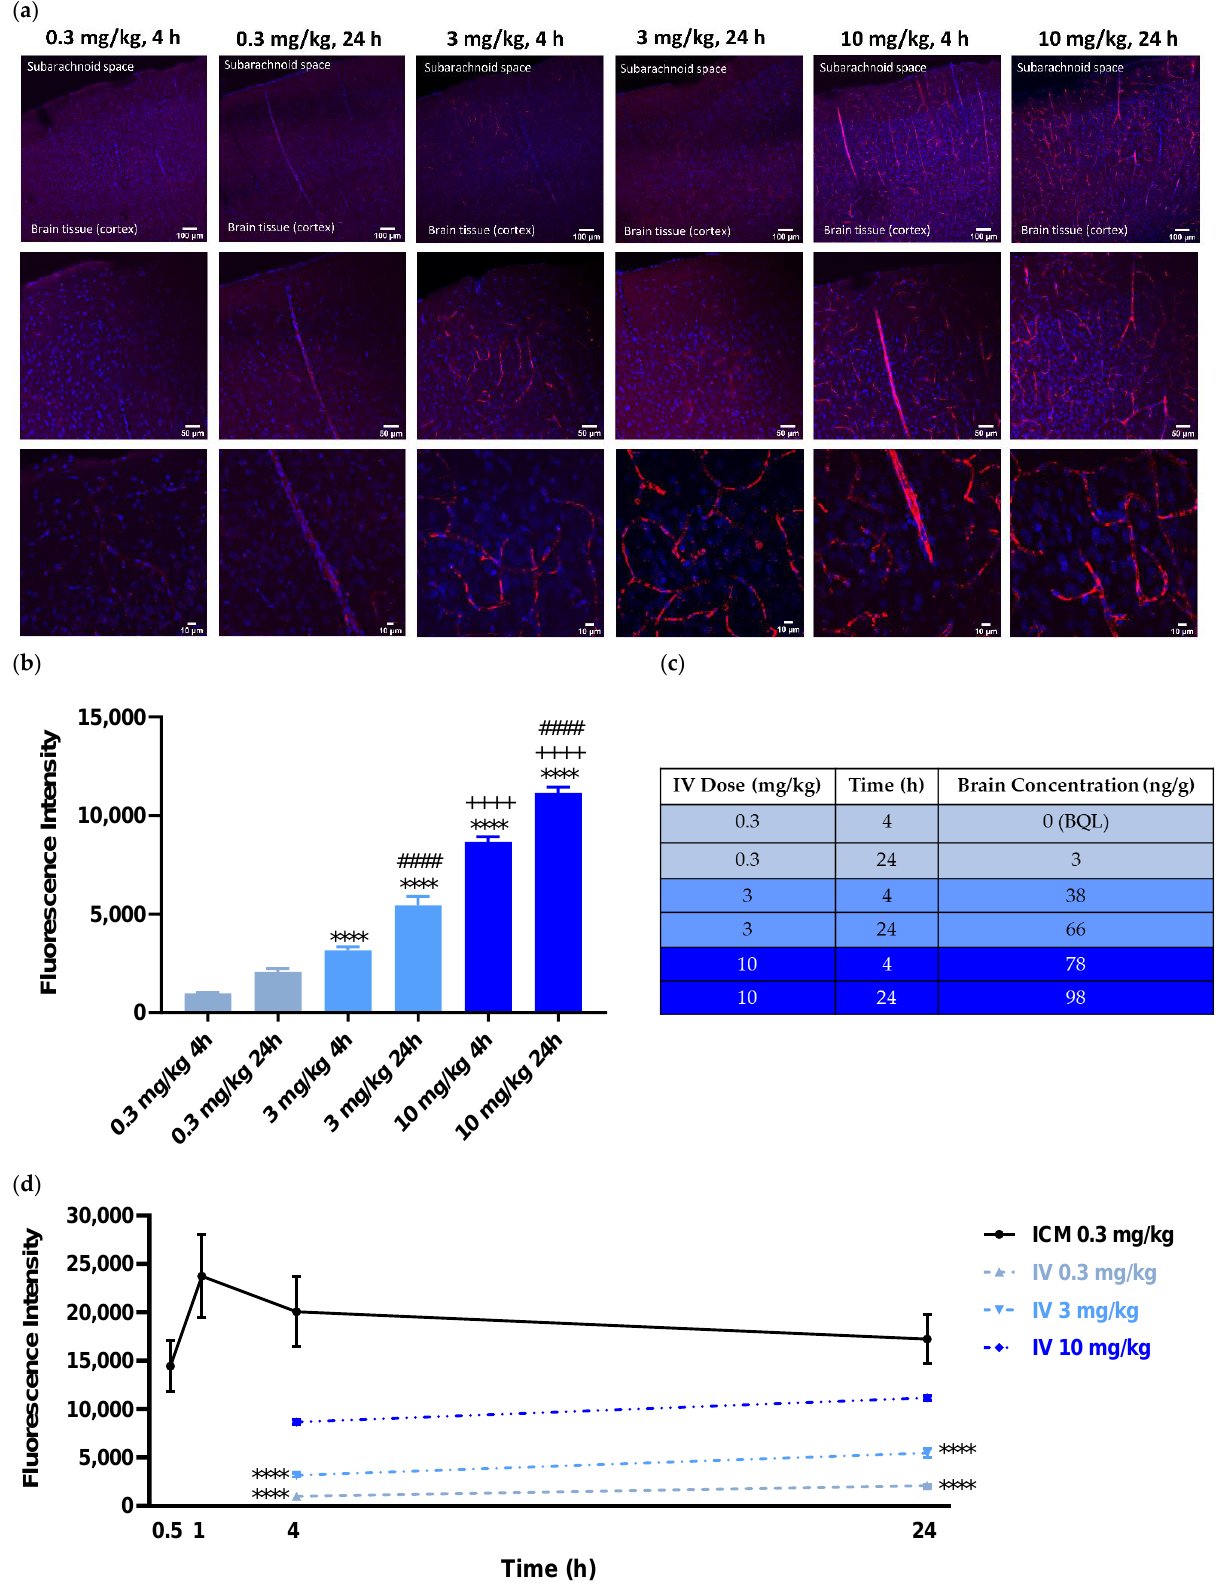
Figure 2. Intravenous (IV) Cortical Biodistribution Data. At equal dose, the tissue penetration of the parent IgG1 antibody administered via the rat tail vein was an order of magnitude lower than when administered intra-CSF. Representative images. ( a ) Upon IV delivery of ABT-806 at 0.3 mg/kg